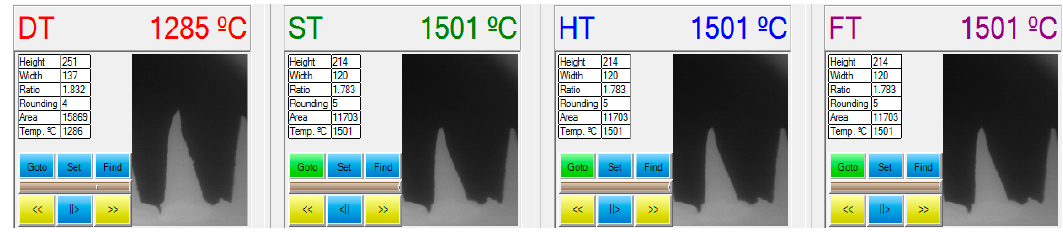
Figure 6. Measurement of ash sample SPS-80/20.